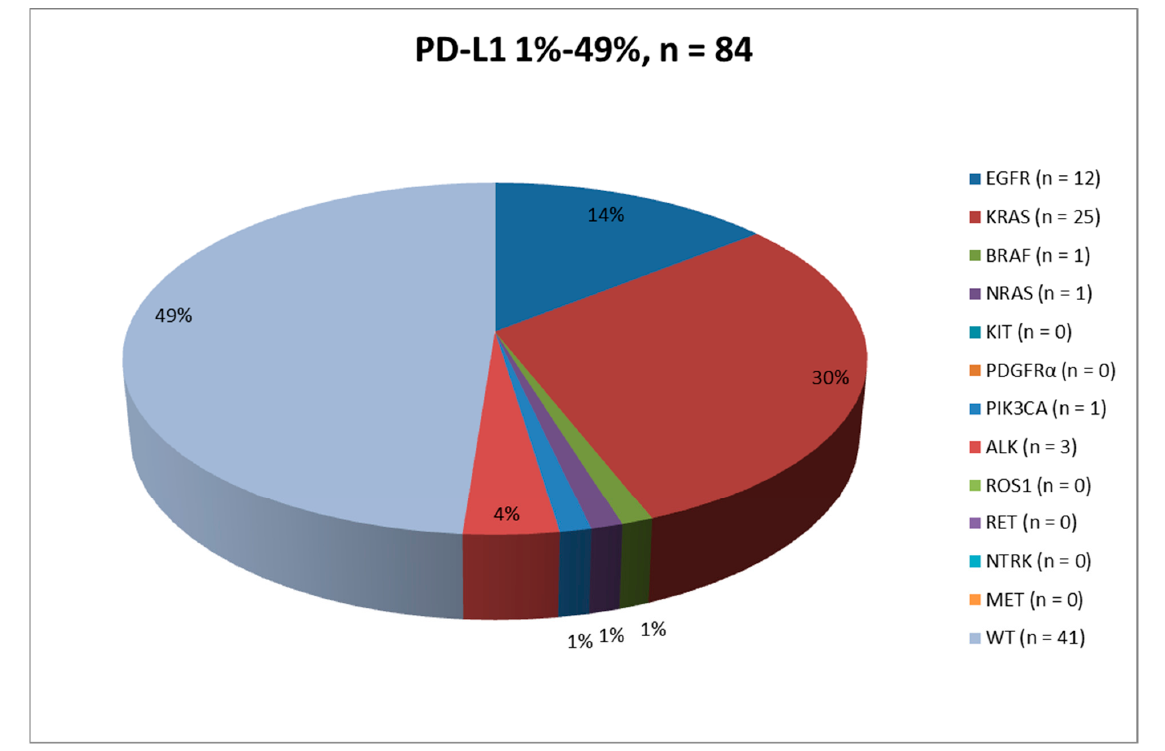
Figure 2. Pie chart describing the mutational landscape in the 1–49% PD-L1 positive advanced stage NSCLC patients population.